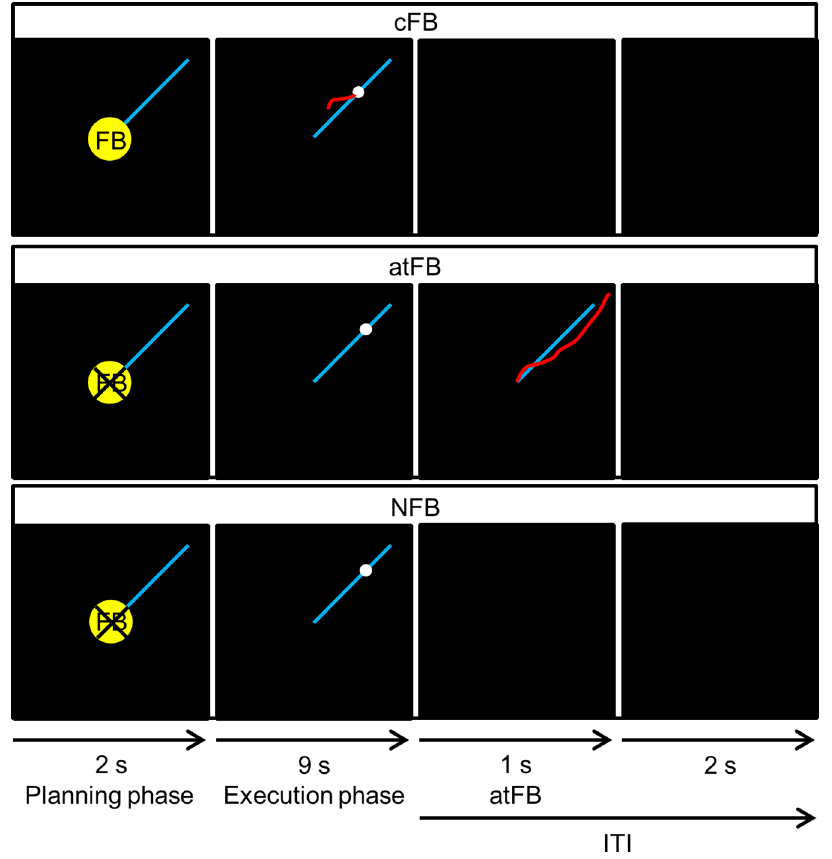
Figure 2. Three types of FB conditions. Concurrent visual feedback, provided by a red cursor indicative of subjects’ current position, was only provided in the concurrent visual feedback (cFB) condition. In the after-trial feedback (atFB) condition, a motionless representation of the produced red line was provided after the execution phase while no feedback was provided during the execution phase. In the no feedback (NFB) condition, no concurrent or after-trial feedback was provided. Every trial started with a planning phase of 2 s where a yellow cue, which indicated whether cFB would be given in the upcoming trial, was presented. During the execution phase, the white target dot moved with constant speed along the blue target line for 9 s. In each condition, the inter-trial interval (ITI), i.e. the time between each trial where no movement was required, lasted 3 s. During ITI, atFB was provided for 1 s in the atFB condition. Instead, a black screen was presented in the cFB and NFB condition.